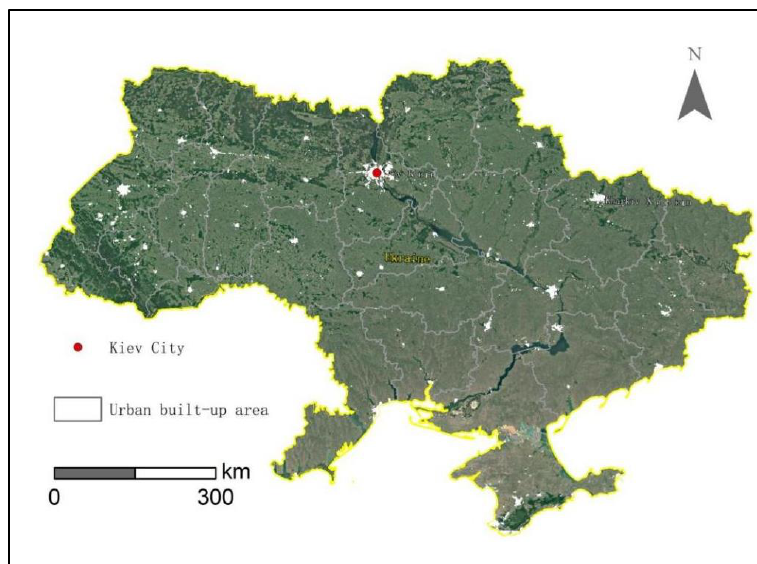
Figure 3. Ukrainian urban built-up areas. More than 60 percent of the country ’ s night-time light was lost after the conflict broke out. We analyzed the dynamic change of night-time light by combining the military clashes and strategies between Russia and Ukraine. By screening the data published by online media, key information affecting the development of the conflict, such as urban control, humanitarian aid, and other key data, can be obtained, as shown in Table 1. Sev- eral cities are taken as examples to determine the ways in which different events of the conflict have affected night-time light. Table 1. Ukrainian cities in military conflict situations. There are three types of cities analyzed here, namely cities in the RC (Russian-controlled area), cities in the UC (Ukrainian-controlled area), and cities in the B (belligerence/conflict area). The plus sign indicates whether a specific event has pro- moted night-time light restoration, and a minus sign indicates no light restoration prompted by an event. State